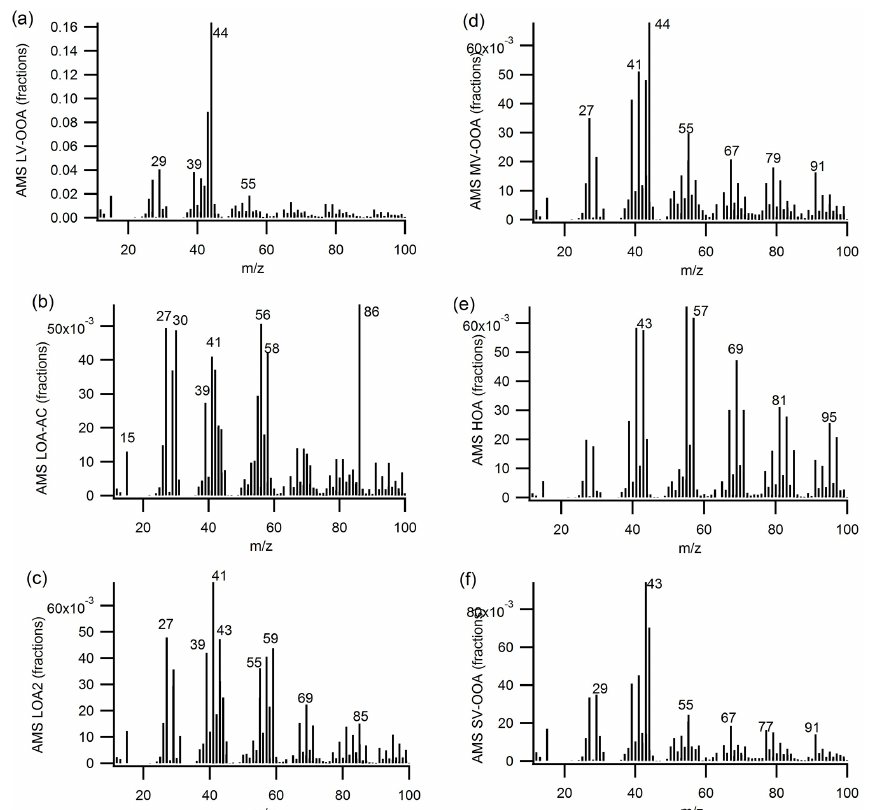
Figure 7. The mass spectra of AMS six components.